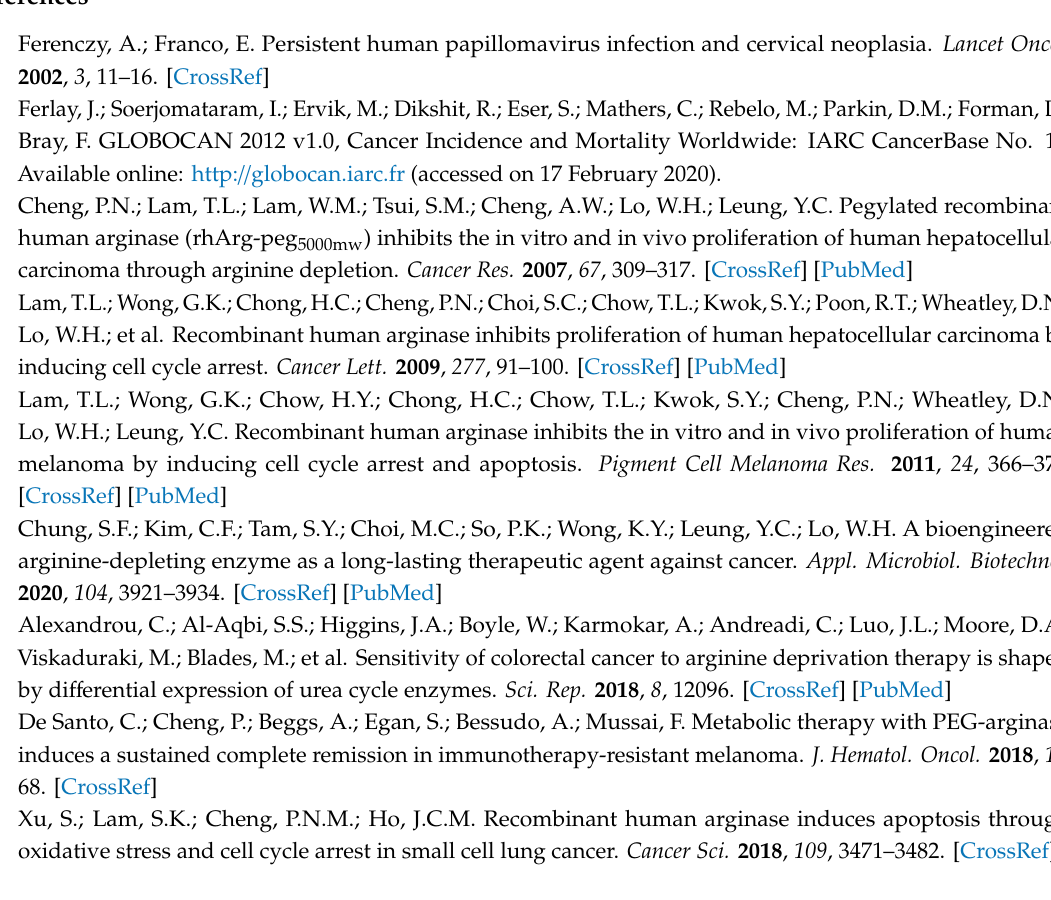
Figure S1: Representative results showing the e ff ect of BCA-M on cell cycle phase distribution of HeLa cells determined using flow cytometric analysis with propidium iodide (PI) staining and RNase digestion. Figure S2: Representative results showing the e ff ect of BCA-M on cell cycle phase distribution of ME-180 cells determined using flow cytometric analysis with propidium iodide (PI) staining and RNase digestion; Figure S3: Representative results showing the e ff ect of BCA-M on cell cycle phase distribution of SiHa cells determined using flow cytometric analysis with propidium iodide (PI) staining and RNase digestion; Figure S4: Representative results showing the e ff ect of BCA-M on apoptosis induction in C-33A cells determined using flow cytometric analysis with Annexin V-FITC and propidium iodide (PI) staining; Figure S5. Representative results showing the e ff ect of BCA-M on apoptosis induction in SiHa cells determined using flow cytometric analysis with Annexin V-FITC and propidium iodide (PI) staining; Figure S6. Representative results showing the e ff ect of BCA-M on apoptosis induction in HeLa cells determined using flow cytometric analysis with Annexin V-FITC and propidium iodide (PI) staining; Figure S7. Representative results showing the e ff ect of BCA-M on apoptosis induction in ME-180 cells determined using flow cytometric analysis with Annexin V-FITC and propidium iodide (PI) staining; Figure S8. HeLa and SiHa cells were treated with 0.4–1.6 U / ml of BCA-M for 1 h; Figure S9. Growth inhibition of CQ on HeLa and SiHa human cervical cancer